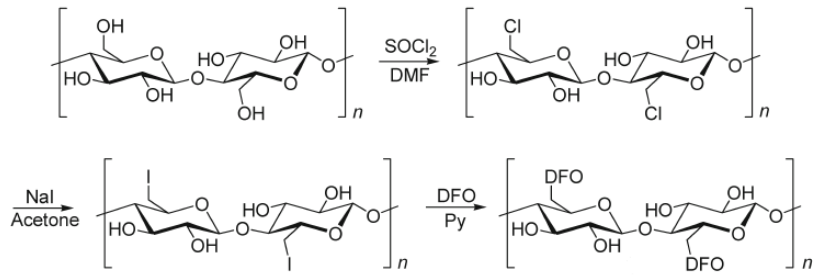
Figure 3. Preparation of papers functionalized by deferoxamine (DFO-papers) [43,69].